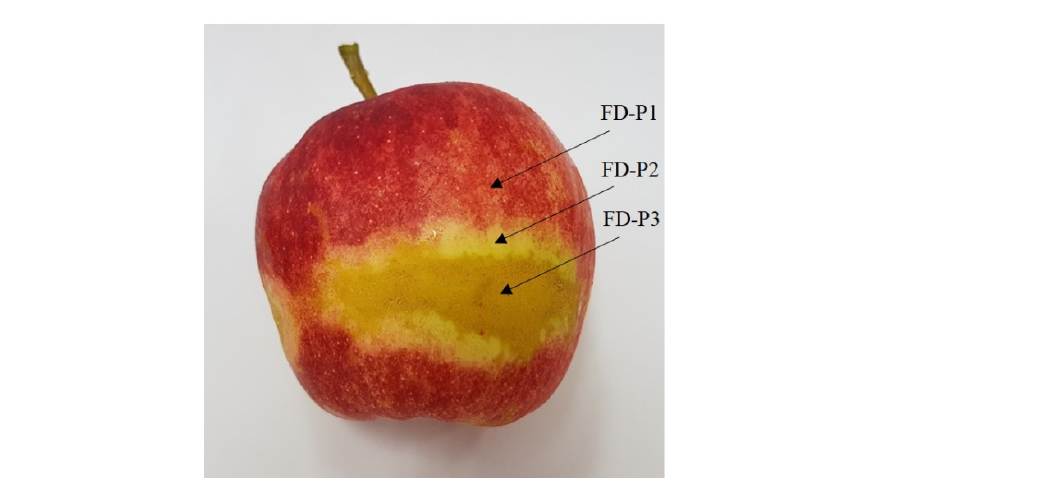
Figure 1. Peel samples from frost damaged apples: healthy peel (FD-P1), discoloured boundary (FD-P2), corky peel (FD-P3).